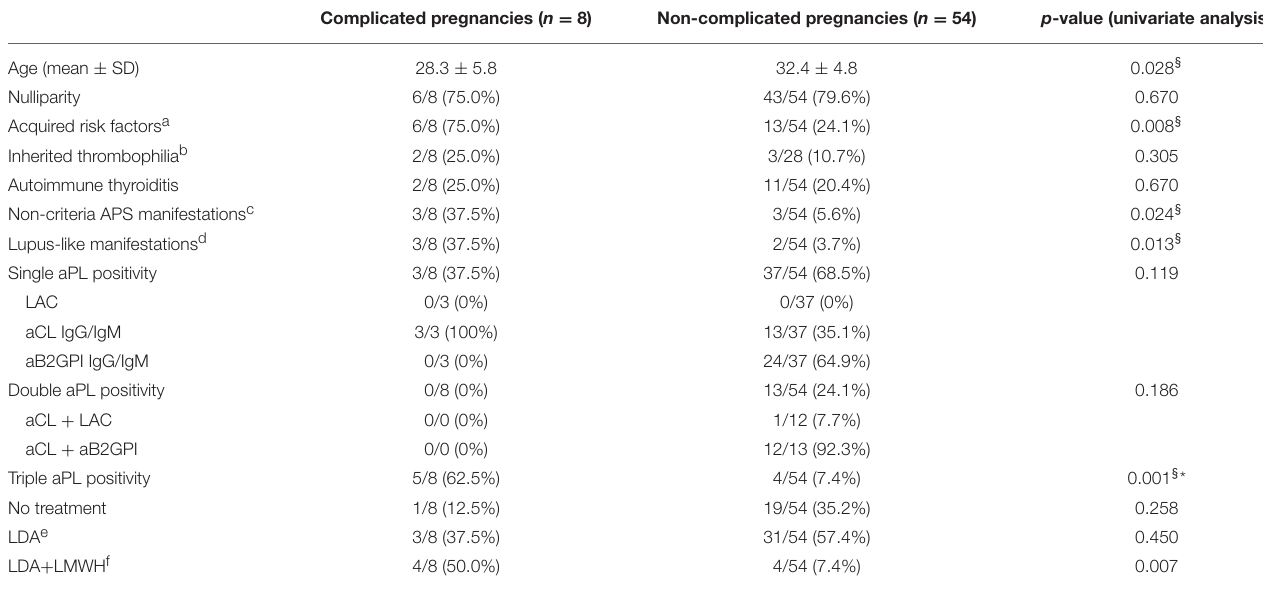
TABLE 3 | Comparison between complicated and non-complicated pregnancies: univariate and multivariate analysis. Complicated pregnancies ( n =